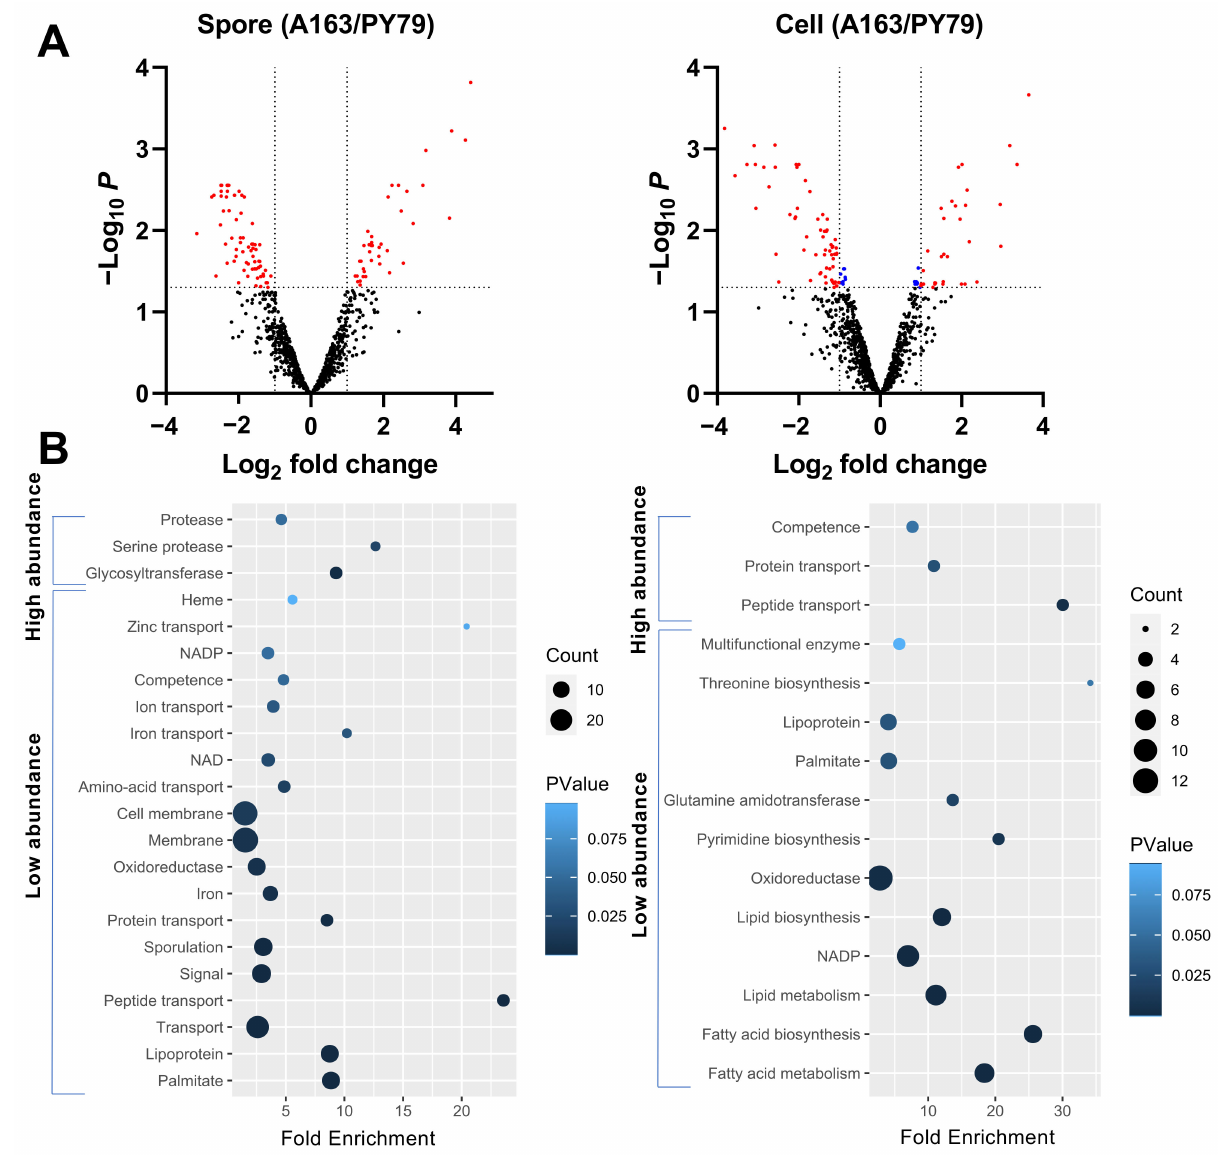
Figure 4. Quantitative comparison of proteomes in spores and cells of B. subtilis PY79 and A163. ( A ) Volcano plots of the quantified proteins in spores of the two strains and the proteome comparison of their correspondent cells. Log 2 fold changes smaller than 0 (or larger than 0) indicate proteins with low (or high) abundance in B. subtilis A163. Dots in red indicate proteins in B. subtilis A163 that were differentially present more than twofold with p < 0.05. Dots in blue indicate proteins that were present with Scheme 0. but less than twofold. ( B ) Uniprot categories enrichment of the differentially presented proteins in spores and cells of B. subtilis A163. The fold enrichment is defined as the ratio of two proportions. The first proportion is the quantified proteins belonging to a UniProt category divided by all high- (or low-) abundant proteins. The second proportion is all proteins belonging to the UniProt category in the genome divided by the total proteins in the genome. The size of the dots is indicative of the number of quantified proteins (Count) belonging to a particular term, as shown in the legend. The color of the dots is corresponding to the Fisher exact p-value (PValue), again as shown in the